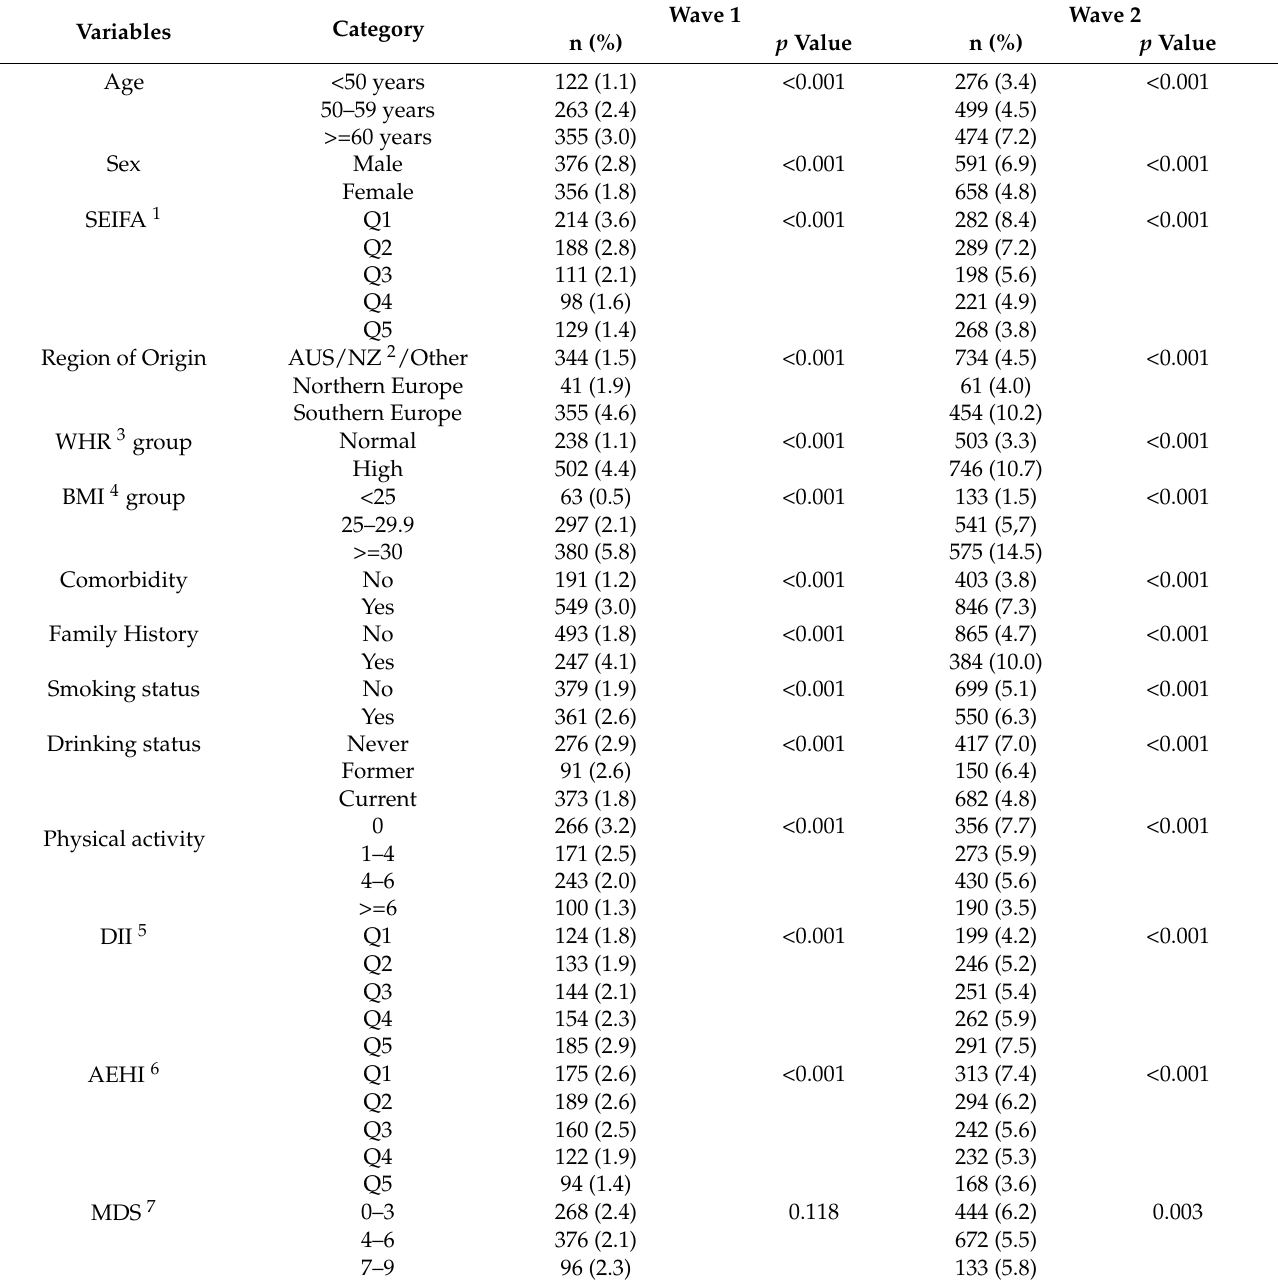
Table 2. Cumulative incidence of diabetes in follow-up (wave) 1 and follow-up (wave) 2 across predictor categories.